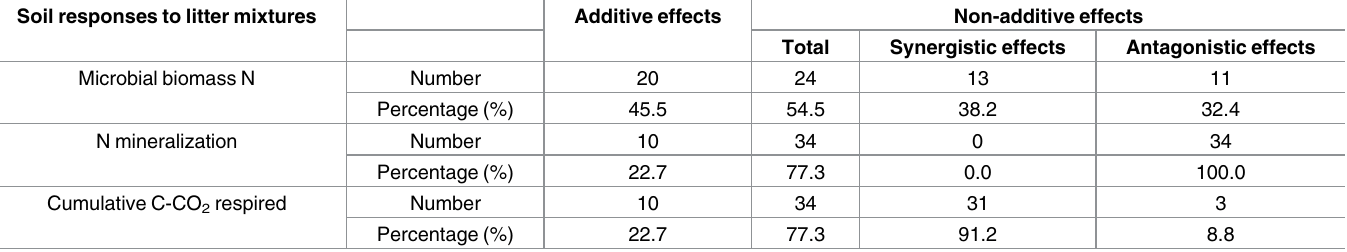
Table 3. The number and percentage of additive effectsand non-additive effects of species mixing on soil microbial biomass N, soil N mineraliza- tion and soil respiration.